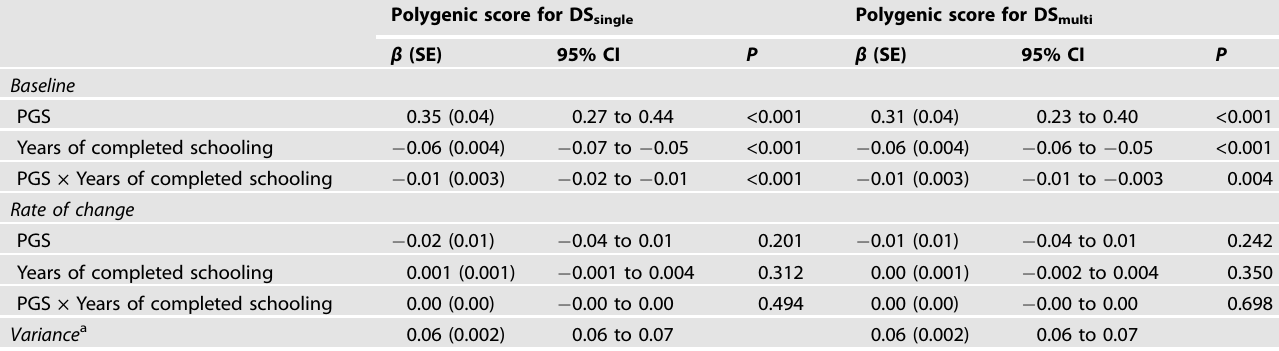
× represents an interaction between the two factors; interactions are presented based on multiplicative interaction model. PGS polygenic score, DS depressive symptoms, CI con fi dence intervals, SE standard errors. a The estimated variance captured random or stochastic variability in the data that comes from participants, here showing that there were signi fi cant individual differences in measure of depressive symptoms over time. The models are adjusted for sex, age and genetic ancestry as captured by 10 principal components; to capture the non-linear effects of ageing, we further included age 2 as a